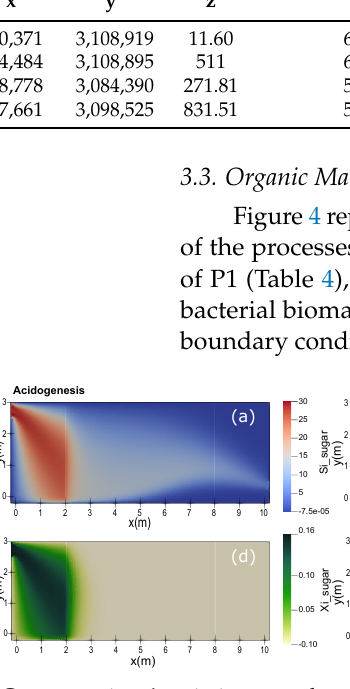
Figure 4. Concentrations’ variation, together with the length and depth of the lagoon, for the example P1. ( a – c ) correspond to substrates, ( d – f ) to